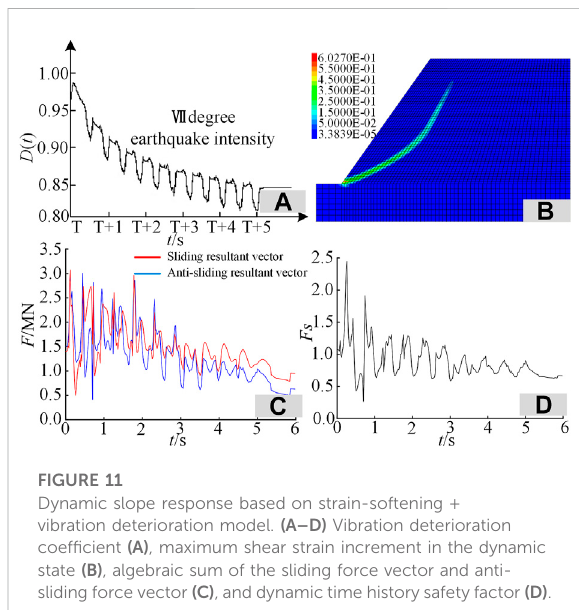
FIGURE 11 Dynamic slope response based on strain-softening + vibration deterioration model. (A – D) Vibration deterioration coef fi cient (A) , maximum shear strain increment in the dynamic state (B) , algebraic sum of the sliding force vector and anti- sliding force vector (C) , and dynamic time history safety factor (D)